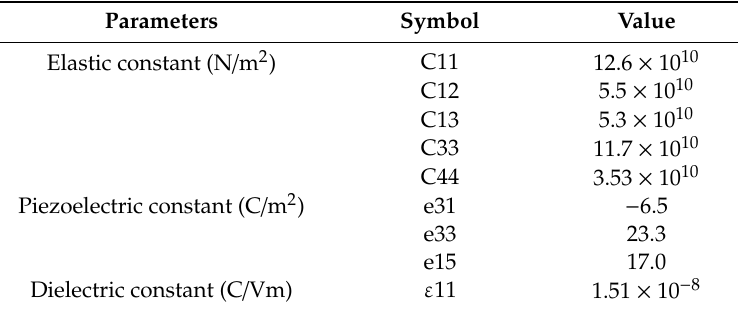
Table 1. The parameters of the pasted piezoelectric ceramic.